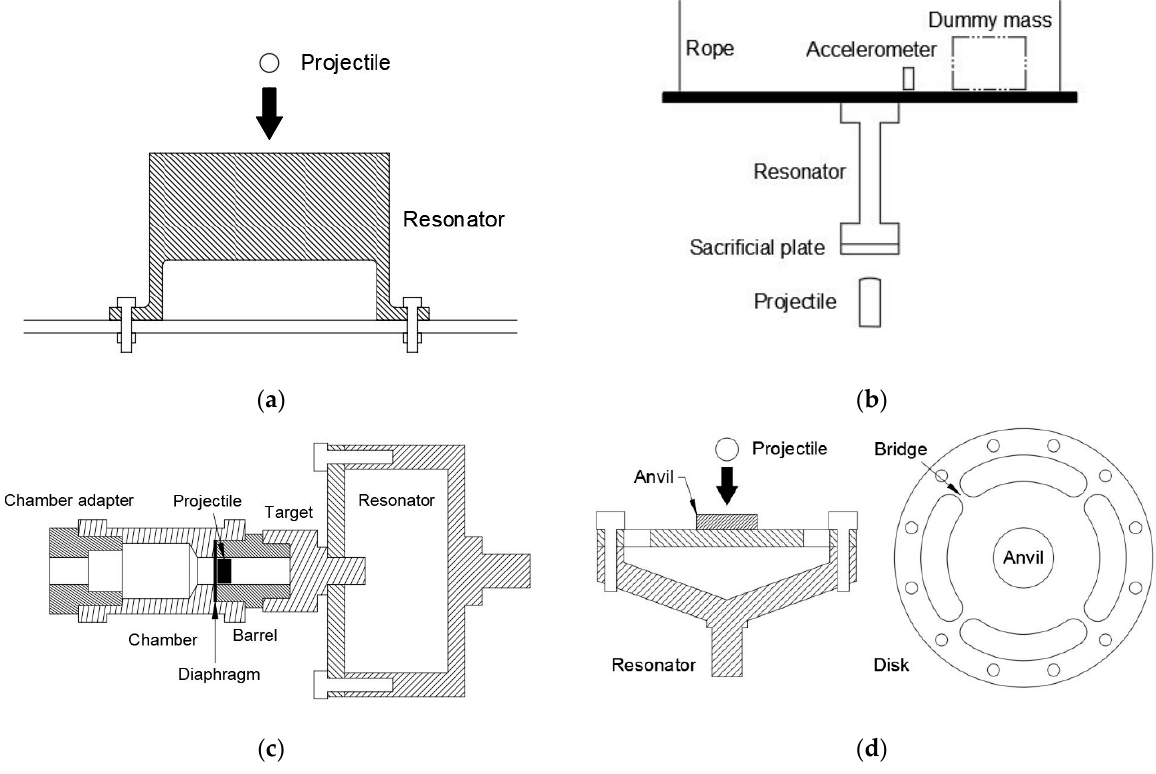
Figure 2. Existing pyroshock simulators: ( a ) Bateman et al.’s pyroshock simulator; ( b ) point ‐ source pyroshock simulator; ( c ) breech method ‐ based pyroshock simulator; ( d ) pyroshock simulator with a launch device.